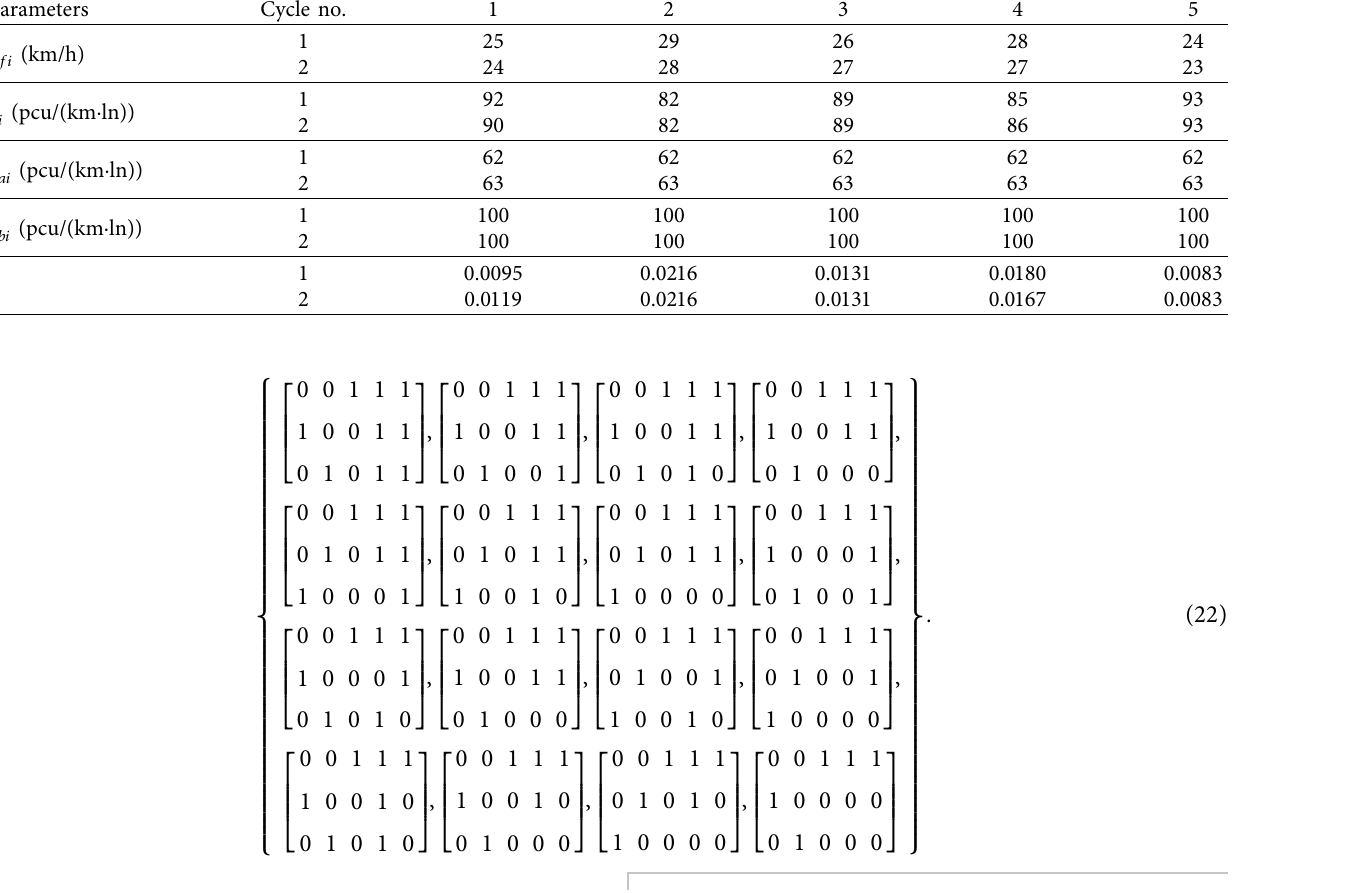
Table 6: Various parameter values of the diverge areas of the target roundabout. Parameters Cycle